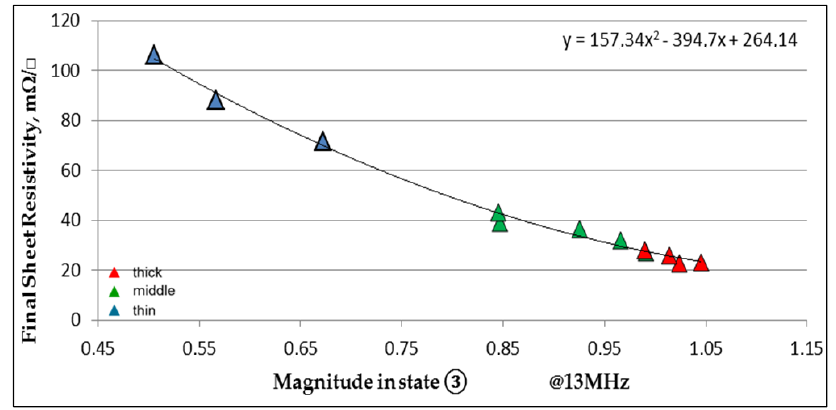
Figure 11. Correlations between the final sheet resistivity and the magnitude in state (3) at a frequency of 13 MHz for Cu/Ag films.